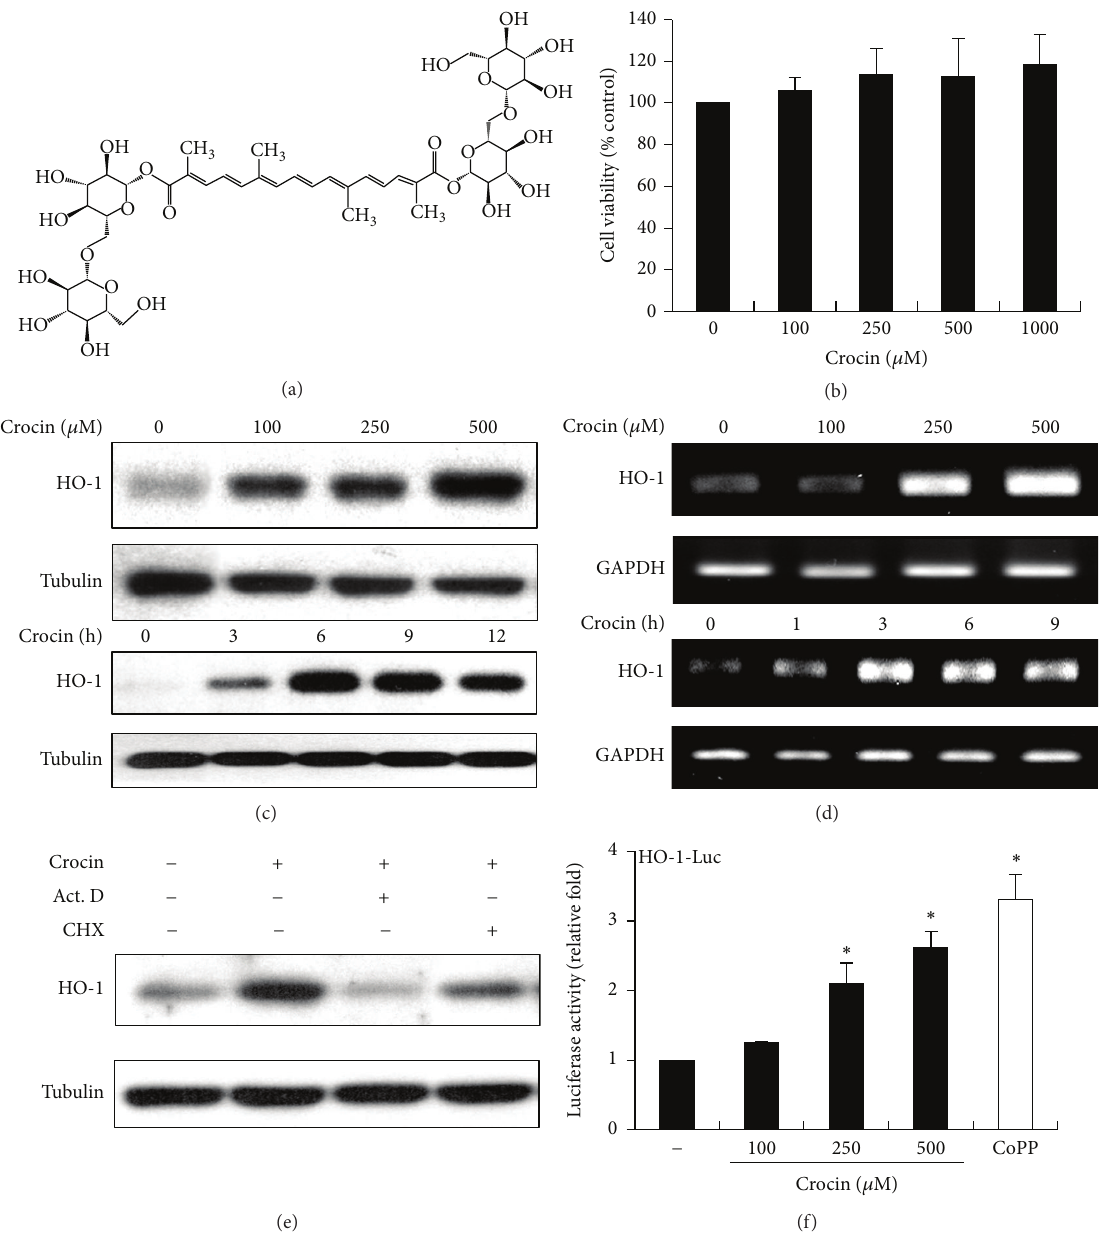
Figure1:InductionofHO-1bycrocin.(a)Chemicalstructureofcrocin.(b)RAW264.7cellswereincubatedwiththeindicatedconcentrations of crocin for 24 h, after which cell viability was measured by MTT assay. (c) RAW 264.7 cells were treated with the indicated concentrations of crocin for 6h (upper panel) or with 500 𝜇 M crocin for various periods (lower panel), and HO-1 protein levels were analyzed by Western blotting. (d) Cells were treated with the indicated concentrations of crocin for 3 h or with 500 𝜇 M crocin for various periods and HO-1 mRNA levels were measured by RT-PCR. (e) Cells were treated with crocin (500 𝜇 M) for 6 h in the presence of Act. D (1 𝜇 g/mL) or CHX (1 𝜇 g/mL), after which protein levels of HO-1 were measured by Western blotting. (f) Cells were transfected with HO-1 promoter-luciferase construct and then treated with the indicated concentration of crocin or CoPP (10 𝜇 M). Equal amounts of cell extracts were then assayed for dual luciferase activity. ∗ 𝑃 < 0.05 versus the group treated with PBS (vehicle). GAPDH and tubulin were used as loading